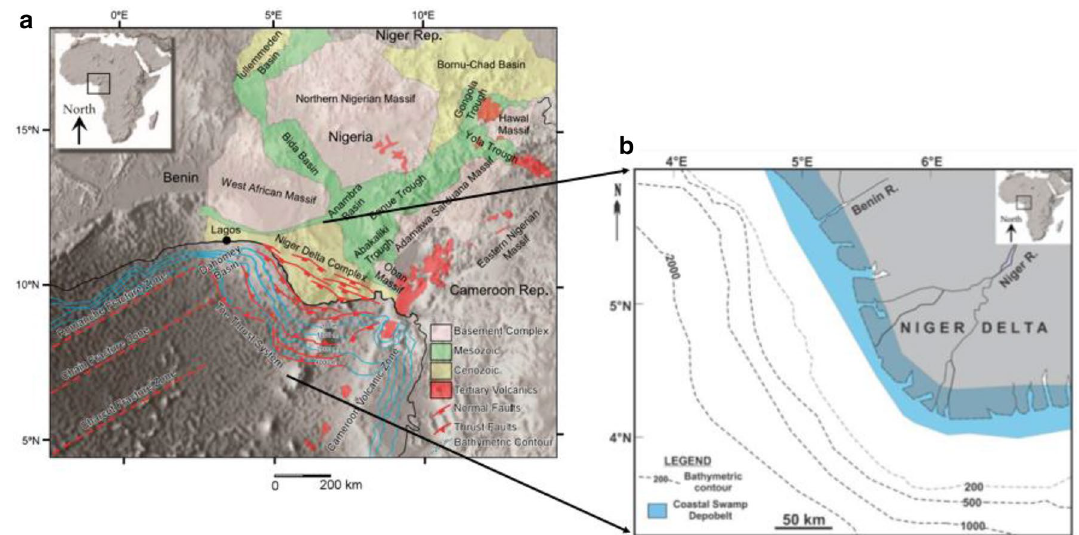
Fig. 1 Map showing a the Niger Delta Basin and other Nigerian sedimentary basins (Corredor et al. 2005). b Location of the study within the coastal swamp depobelt. Modified after Deptuck et al.